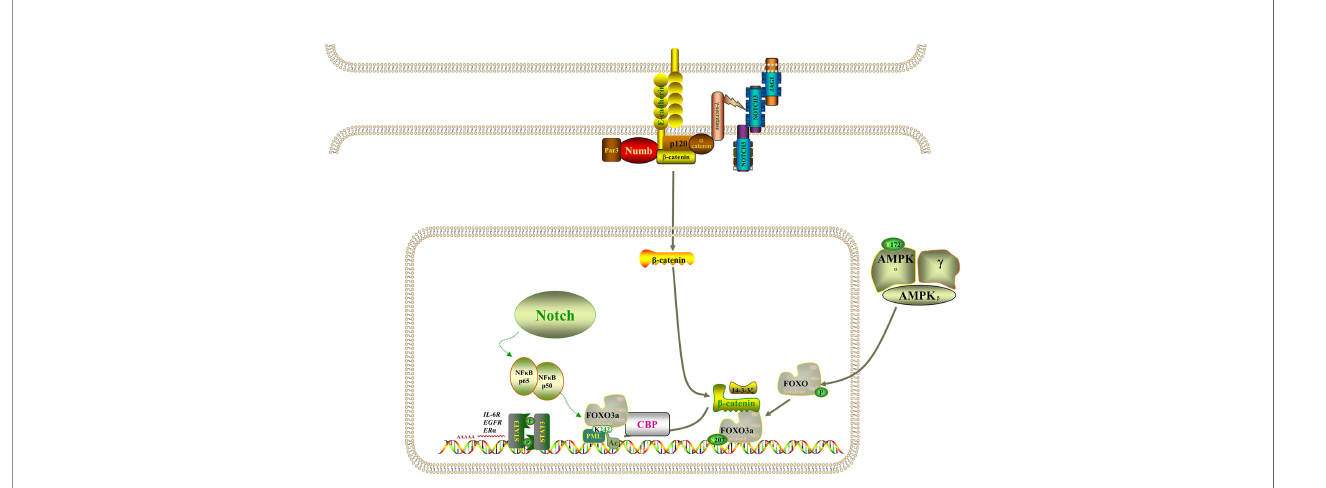
FIGURE 9 | Model of the regulatory signaling networks of Notch3/ b -catenin/FOXO3a in EGFR-TIK resistance and CSC properties of lung